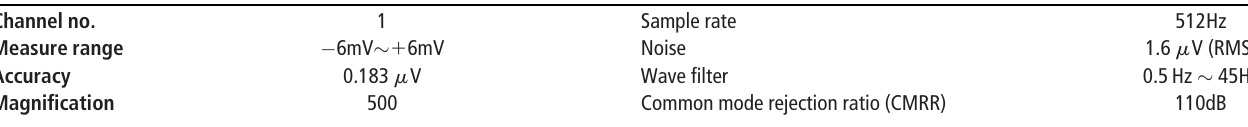
Table I Technical speci fi cations of ECG sensors Channel